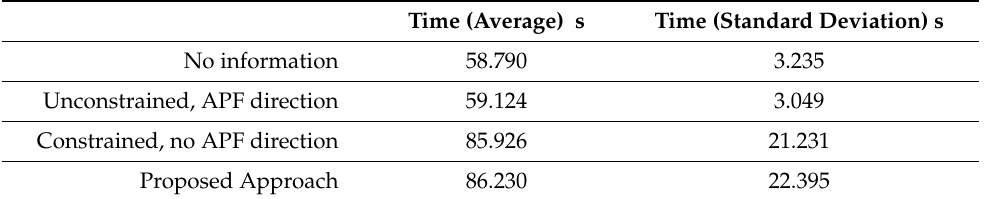
Table 4. Average and standard deviation over 100 trials of the computational time (in seconds) for the computation of the MLE solution via MIDACO-SOLVER for the different operational